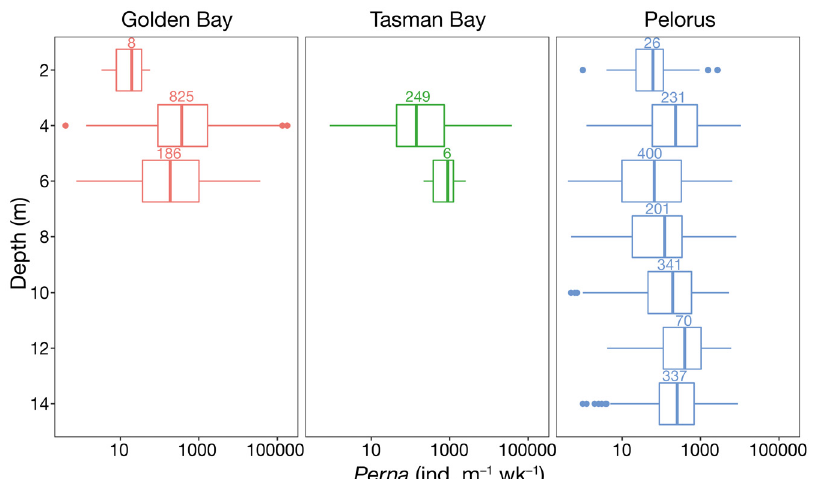
Fig. 4. Overall depth trend of Perna canaliculus spat settlement (ind. m −1 wk −1 ) for Golden Bay, Tasman Bay and Pelorus Sound, aggregated across month and year within each sub-region. Sample size for each depth is shown above each box. Lines in boxes are medians, boxes are the interquartile range, and whiskers extend to the lowest or highest data point ≤ 1.5× the interquartile range. Dots are